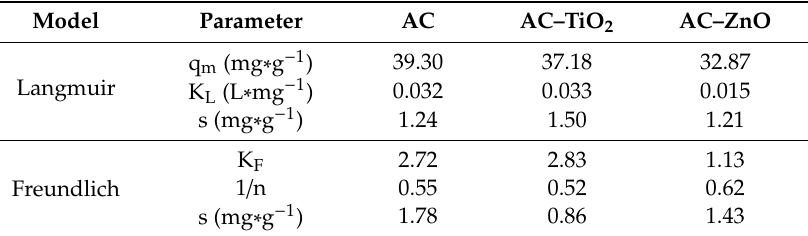
Figure 7. Adsorption isotherms of phenol at 298 K. Table 2. Parameters calculated for Langmuir and Freundlich isotherm models.